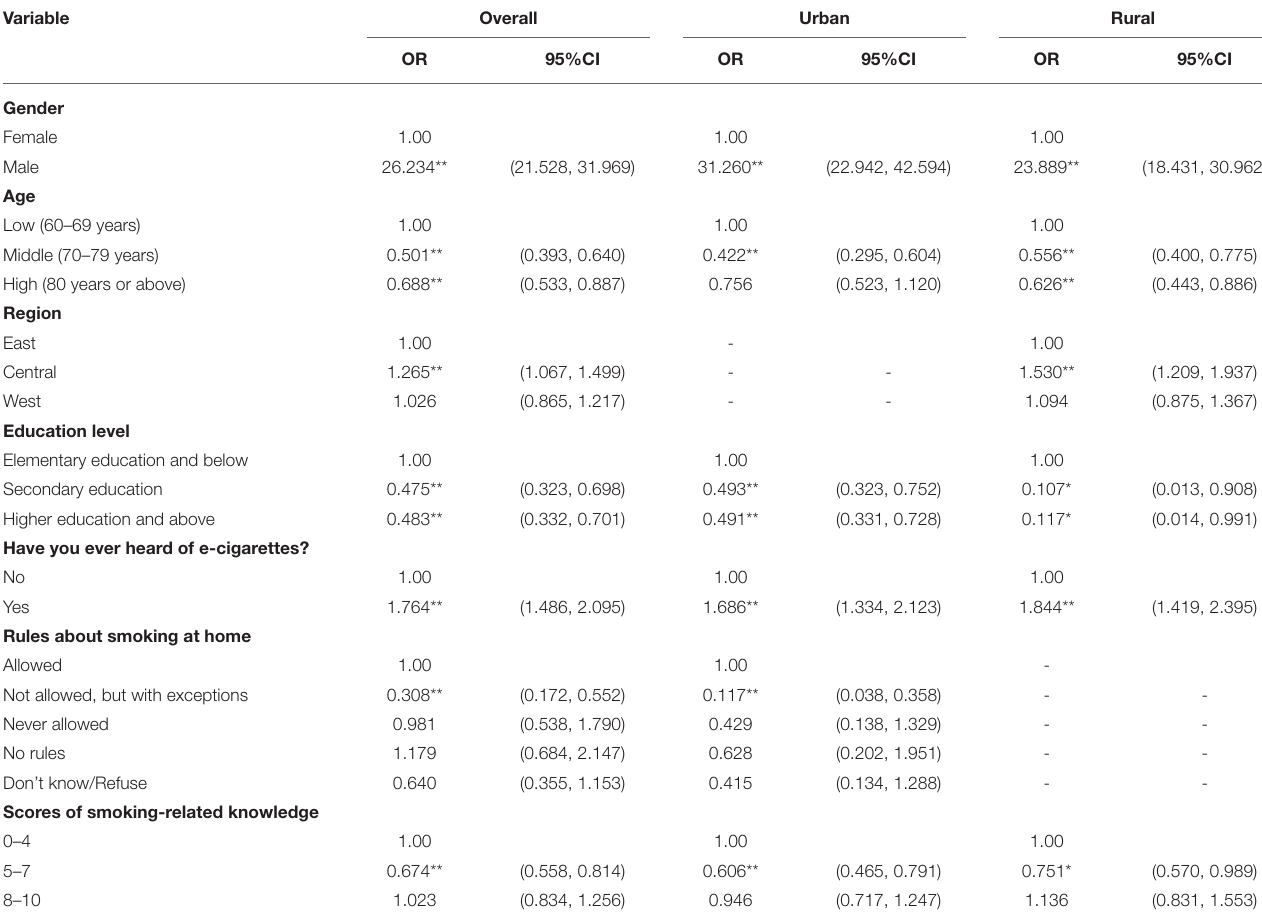
TABLE 7 | Results of the logistic regression for sociodemographic characteristics associated with smoking status.